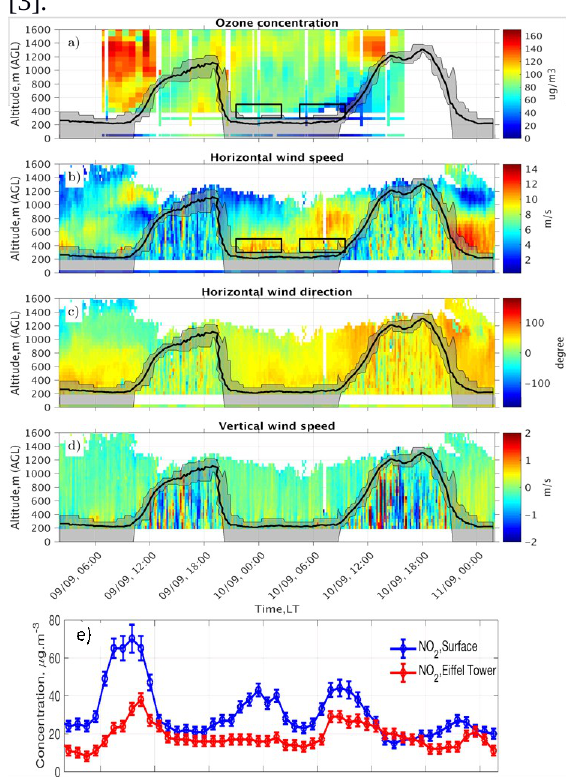
Fig. 3: Time evolution on 9 and 10 September of lidar O3 concentrations (a), of surface O3 (a) and NO (e) measured at the Eiffel Tower (275m x AGL) and the Paris13 station (5m AGL), of the horizontal lidar wind speed (b) and direction (c), of vertical wind speed (d). Surface wind speed and direction measured at Montsouris are also shown in (b) and (c). The PBL height is shown in black with its uncertainty in